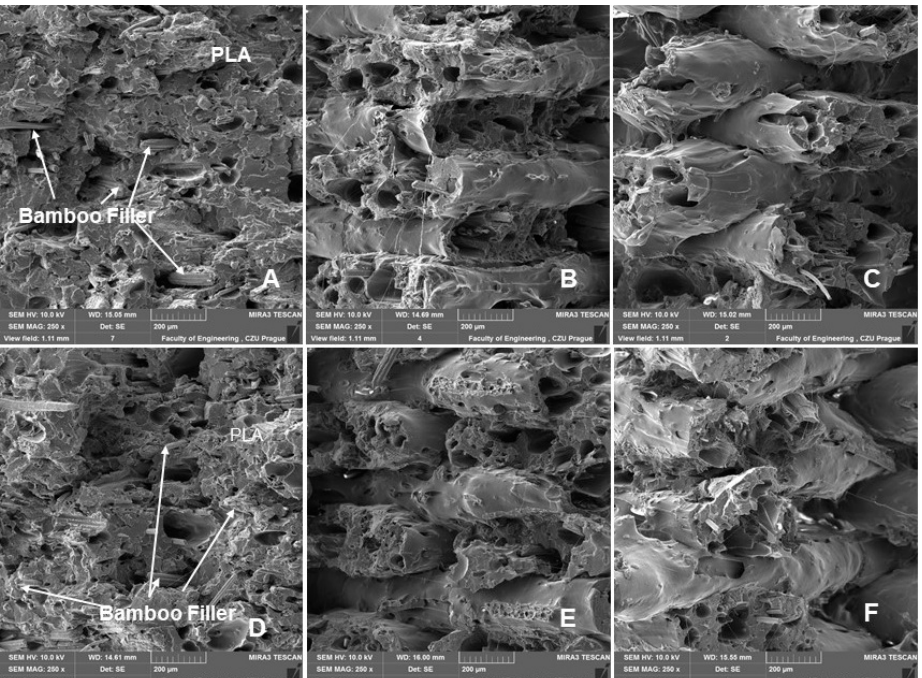
Figure 13. SEM images—fractographic analysis—nozzle 0.4 mm (MAG 2.50×): ( A ): Infill density 100%, static tensile test; ( B ): Infill density 80%, static tensile test; ( C ): Infill density 60%, static tensile test; ( D ): Infill density 100%, low cyclic fatigue; ( E ): Infill density 80%, low cyclic fatigue; ( F ): Infill density 60%, low cyclic fatigue.